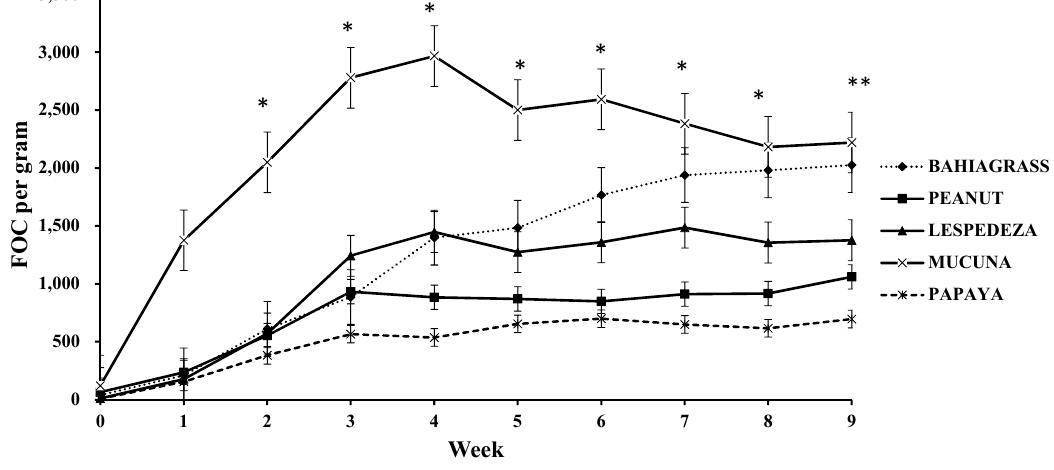
Figure 2. Effects of supplementing bahiagrass (BG) hay with perennial peanut (PEA), lespedeza (LES) hay, mucuna (MUC), or papaya seeds (PAP) on coccidian fecal oocysts counts (FOC). Treatment×time, p<0.05. Error bars are standard errors. * Counts at the week specified differed (p<0.05) and ** counts at the week specified tended to differ